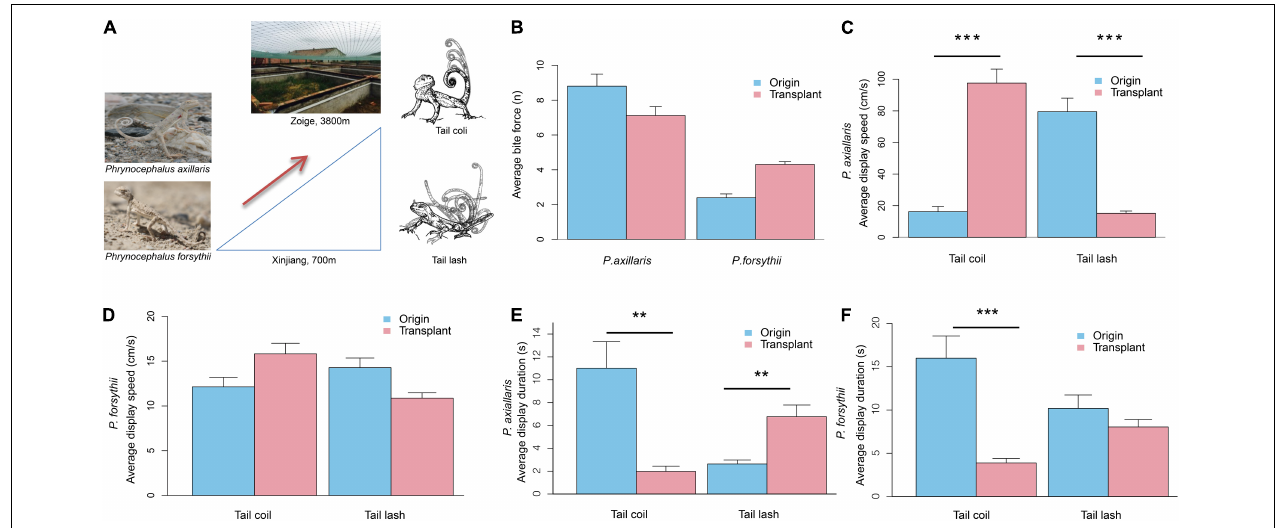
FIGURE 1 | Transplant experimental design and plasticity in performance and behavior for Phrynocephalus axillaris and P. forsythii . (A) Image of P. axillaris and P. forsythii , the outdoor enclosures used for the common garden in Zoige, the eastern part of the Qinghai-Tibetan Plateau in Sichuan Province, and the schematic drawing of tail coil and tail lash for tail displays. (B) Comparison of bite force before and after transplant. (C) Comparison of tail coil speed and tail lash speed before and after transplant for P. axillaris . (D) Comparison of tail coil speed and tail lash speed before and after transplant for P. forsythii . (E) Comparison of tail coil duration and tail lash duration before and after transplant for P. axillaris . (F) Comparison of tail coil duration and tail lash duration before and after transplant for P. forsythii . In (B–F) , bar plots represent the mean values, and error bars represent their standard error. Asterisks indicate statistical significance levels: ** p < 0.01; *** p <